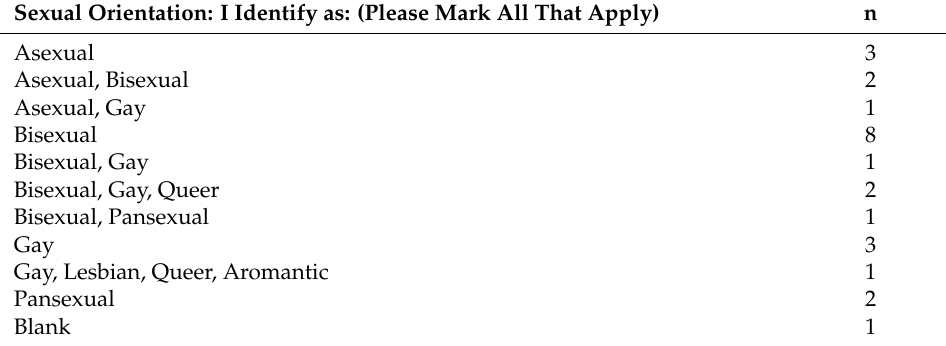
Table 3. Sexual orientation of